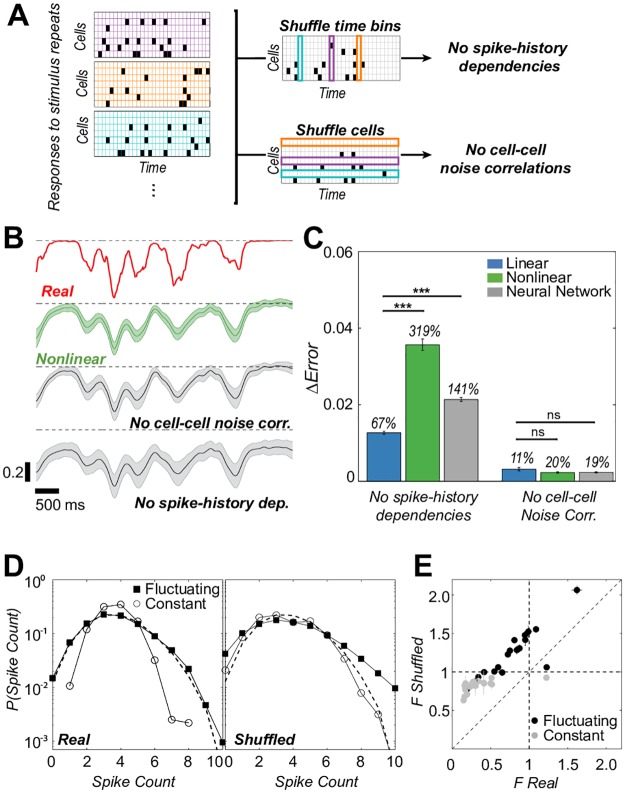
Spike-history dependencies affect decoding performance.A: Shuffles of responses to repeated stimulus presentations remove different types of correlations, but preserve average locking to the stimulus (PSTH), and thus stimulus-induced correlations. B: A repeated stimulus fragment (red trace), nonlinear kernelized decoder predictions using real responses (green), and using responses without different types of correlations (gray); shown is the prediction mean ± SD over repeats. C: Increase in decoding error (MSE) when spike-history dependencies or noise correlations are removed (average ± SEM across sites); percentages report fractional differences relative to the original performance. D: Spike count distributions for a single example cell. Removing spike-history dependencies broadens the distributions, in particular in constant epochs. Dashed line = expectation for a fully randomized spike train with a matched firing rate. E: Variance-to-mean ratio F of spike count distributions for spike trains with and without spike-history dependencies. Each point is a cell that contributes most to decoding at a particular site (when the same cell contributes to multiple sites, average ± SD across sites is shown).